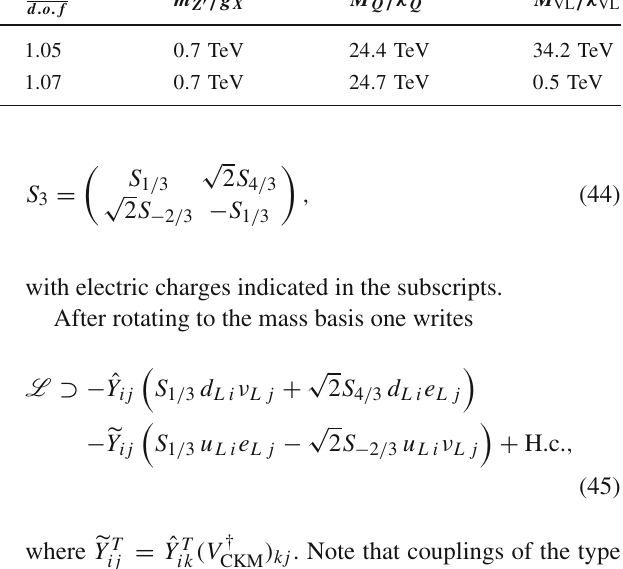
Table 5 Evidence, pull to the SM, chi-squared statistics, and input parameters at the best-fit points of Model 1 and Model 2 Z (cid:4) +